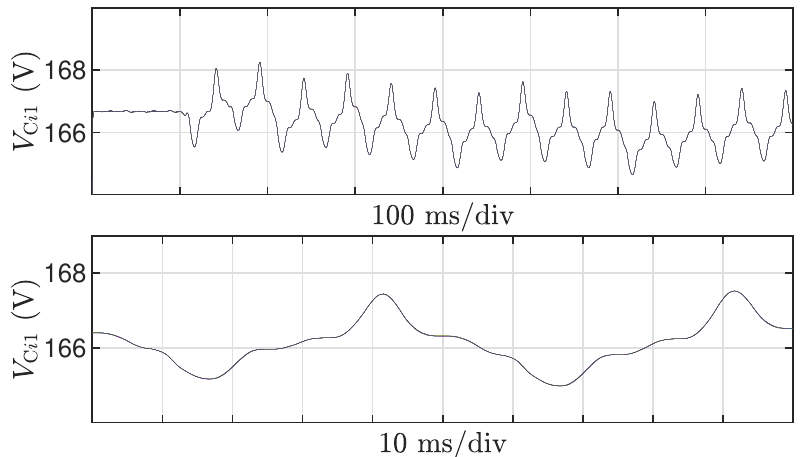
Figure 14. PD–SPWM VBA performance: ( Top ) zoom–out depicting transients at initial conditions; ( Bottom ) zoom–in at